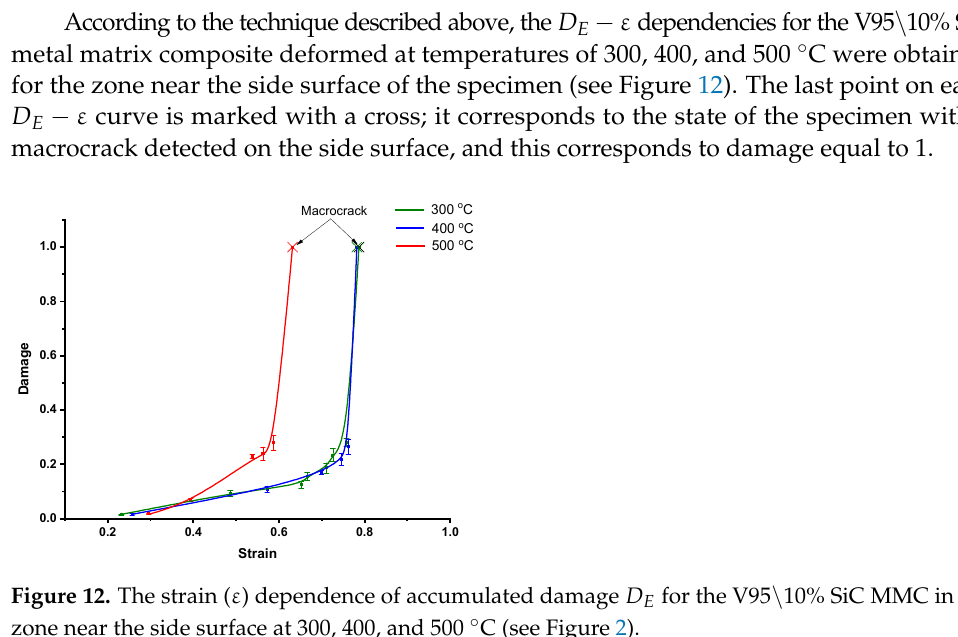
Figure 13. The strain ( ε ) dependence of the stress state indices σ μ ( a ) and k ( b ) in the zone near the side surface of the specimen (see Figure 2) for a temperature range of 300 to 500 ° С ; the accumulated strain field ε ( c ) at the time of mac- rocracking on the side surface of the V95\10% SiC MMC specimens at temperatures ranging from 300 to 500 ° С .